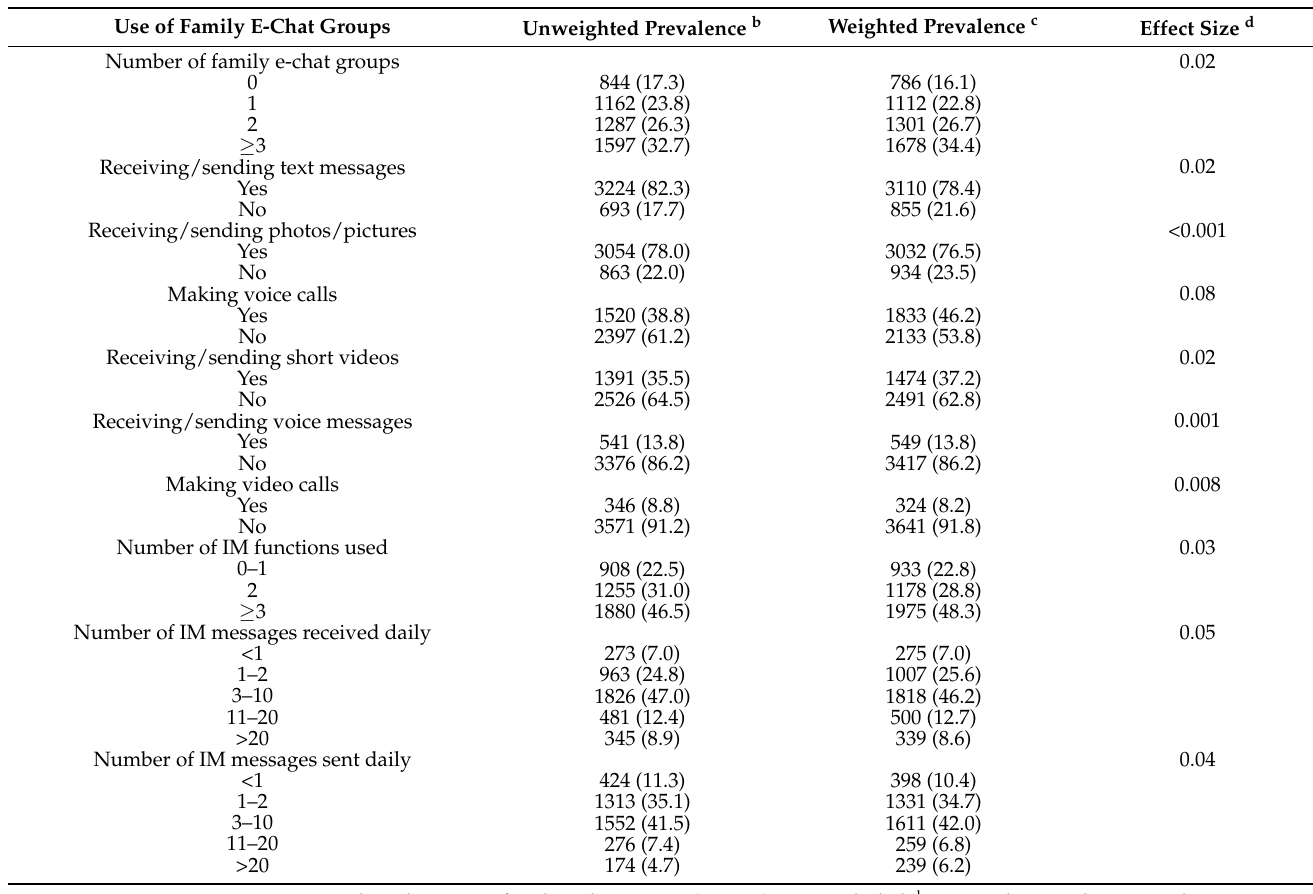
Table 2. Number of family e-chat groups ( n = 4890) and use of IM functions ( n = 4046) a when COVID-19 outbreak was severe, n